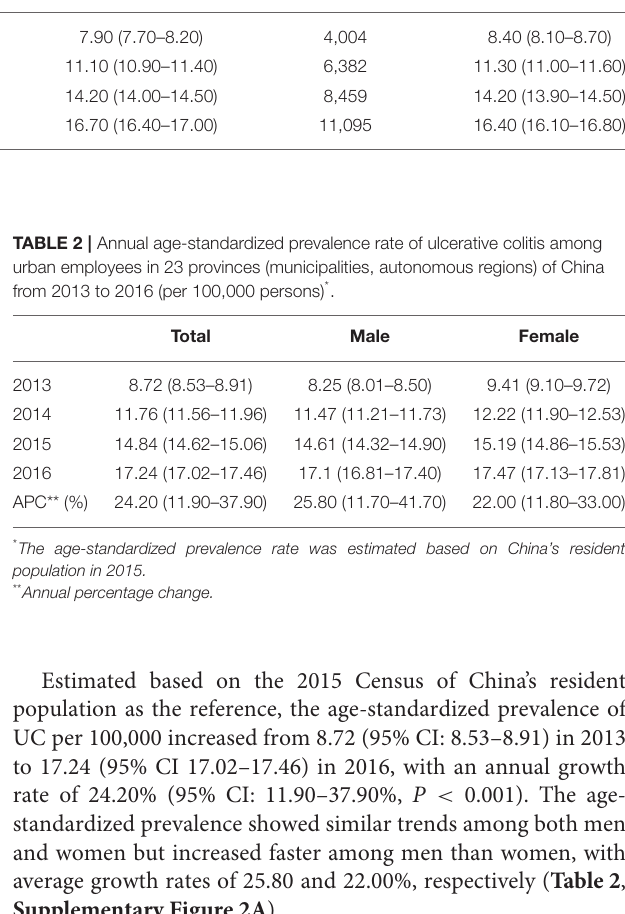
TABLE 1 | Annual crude prevalence rate of ulcerative colitis among urban employees in 23 provinces (municipalities, autonomous regions) of China from 2013 to 2016 (per 100,000 persons). Total Male Female Num. of patients Rate (95%CI*) Num. of patients Rate (95%CI) Num. of patients